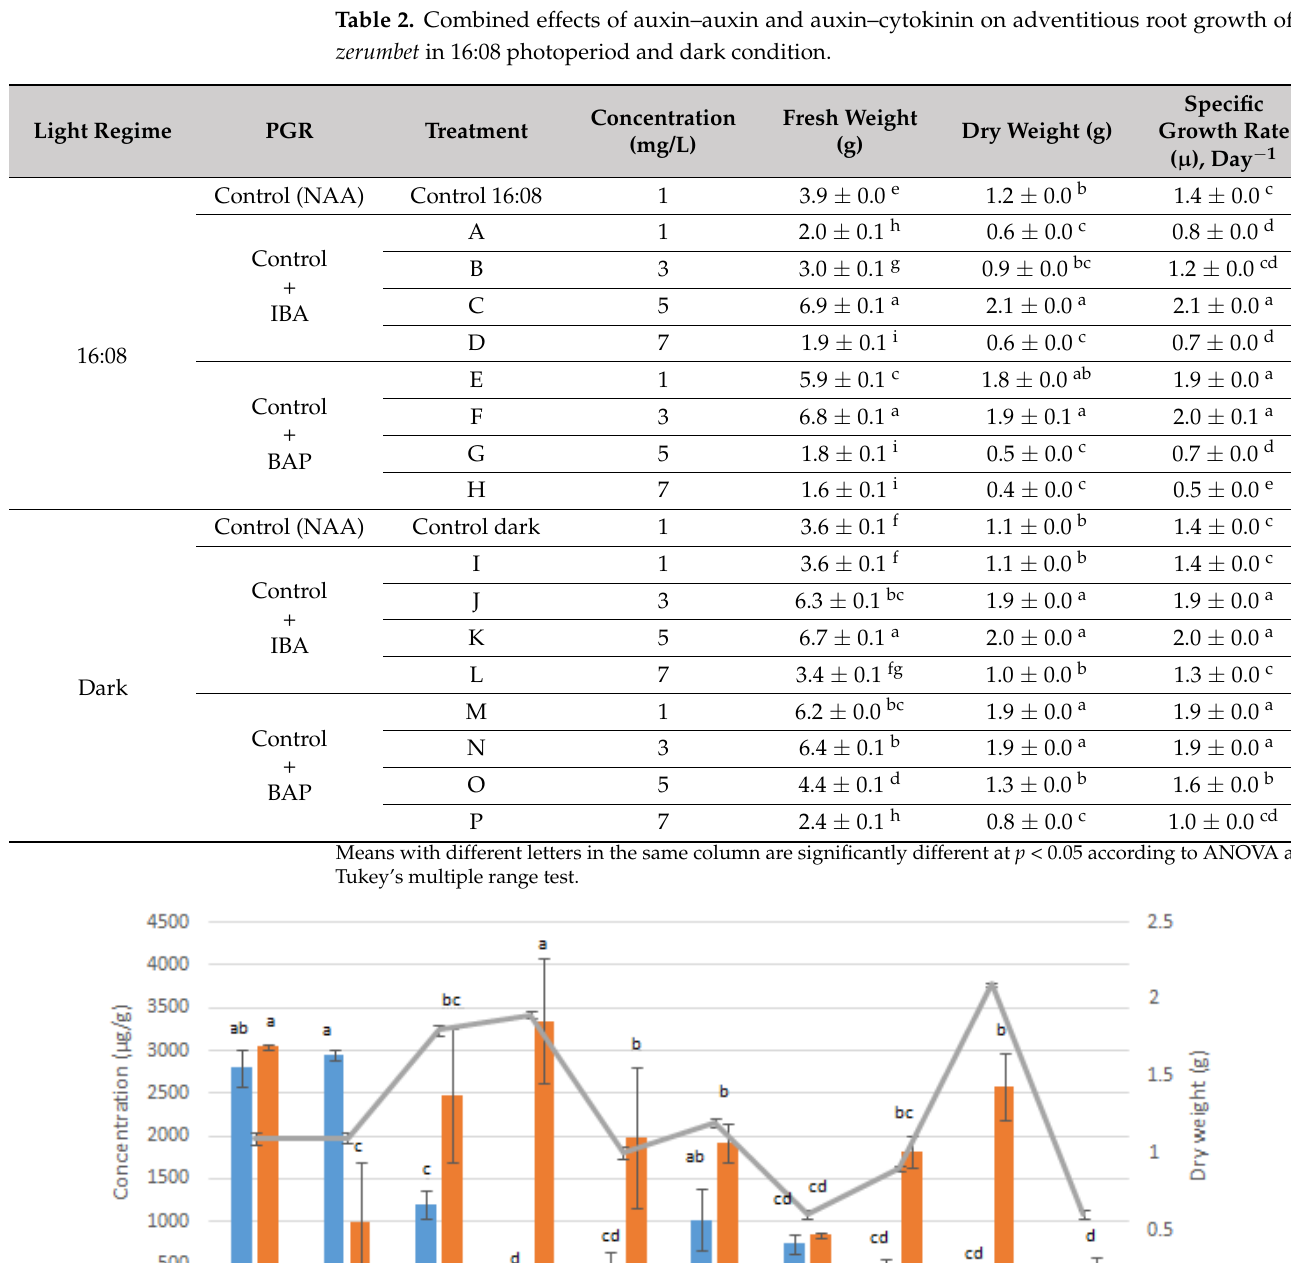
Figure 5. Zerumbone, α -humulene, and root dry weight produced in a combined auxin – cytokinin medium with a 16:08 photoperiod and dark condition. MS media supplemented with 1 mg/L NAA (control) combined with 1, 3, 5, and 7 mg/L BAP (treatments E, F, G, and H, respectively, with a 16:08 photoperiod) or with 1 mg/L NAA (control) added with 1, 3, 5 and 7 mg/L BAP (treatments M, N, O, and P in the dark, respectively). Error bars indicate standard deviation of the mean value. Means with different letters in the same column are significantly different at p < 0.05 according to ANOVA and Tukey’s multiple range test . 3.3. Synergistic Effects of Elicitors on Root Growth and Bioactive Compounds Production In this study, the root yield decreased with increasing concentrations of MeJa and SA, as shown in Figure 4. When the roots were treated with MeJa and SA at higher con-